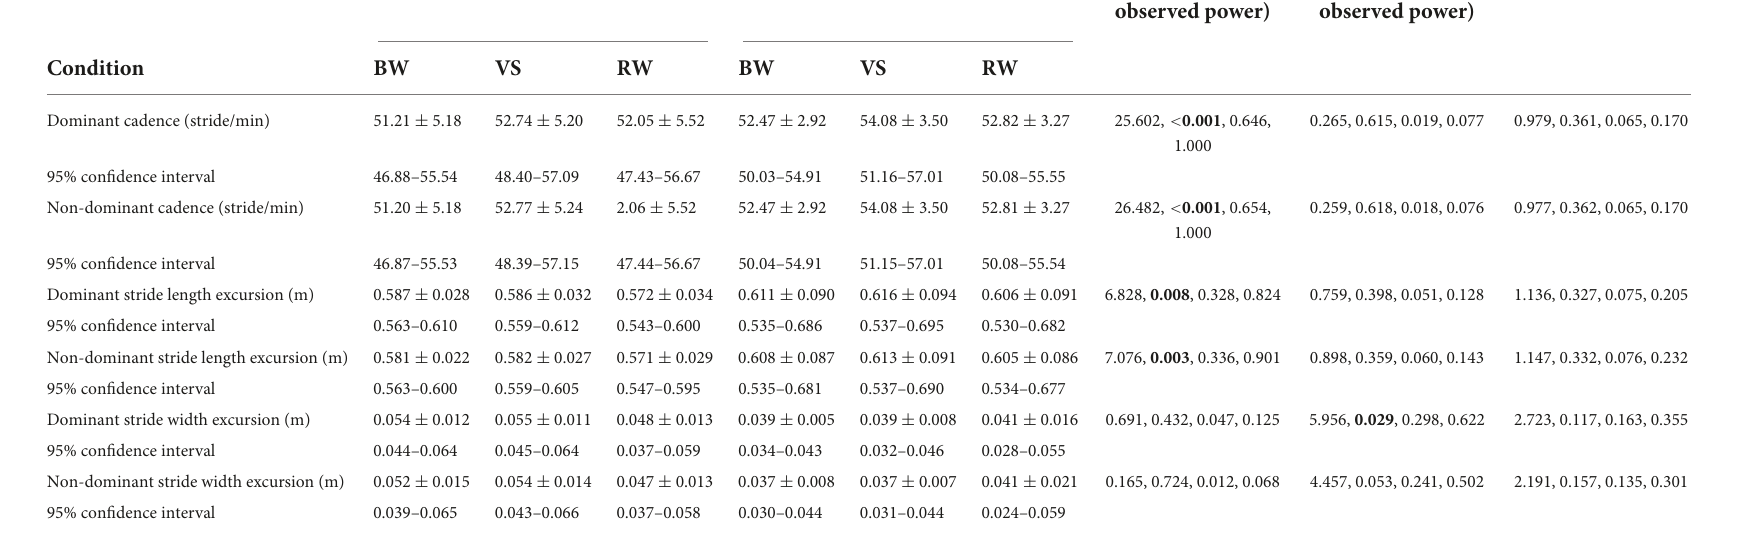
TABLE 3 Gait parameters among walking conditions and between groups. Group CP TD Between-condition